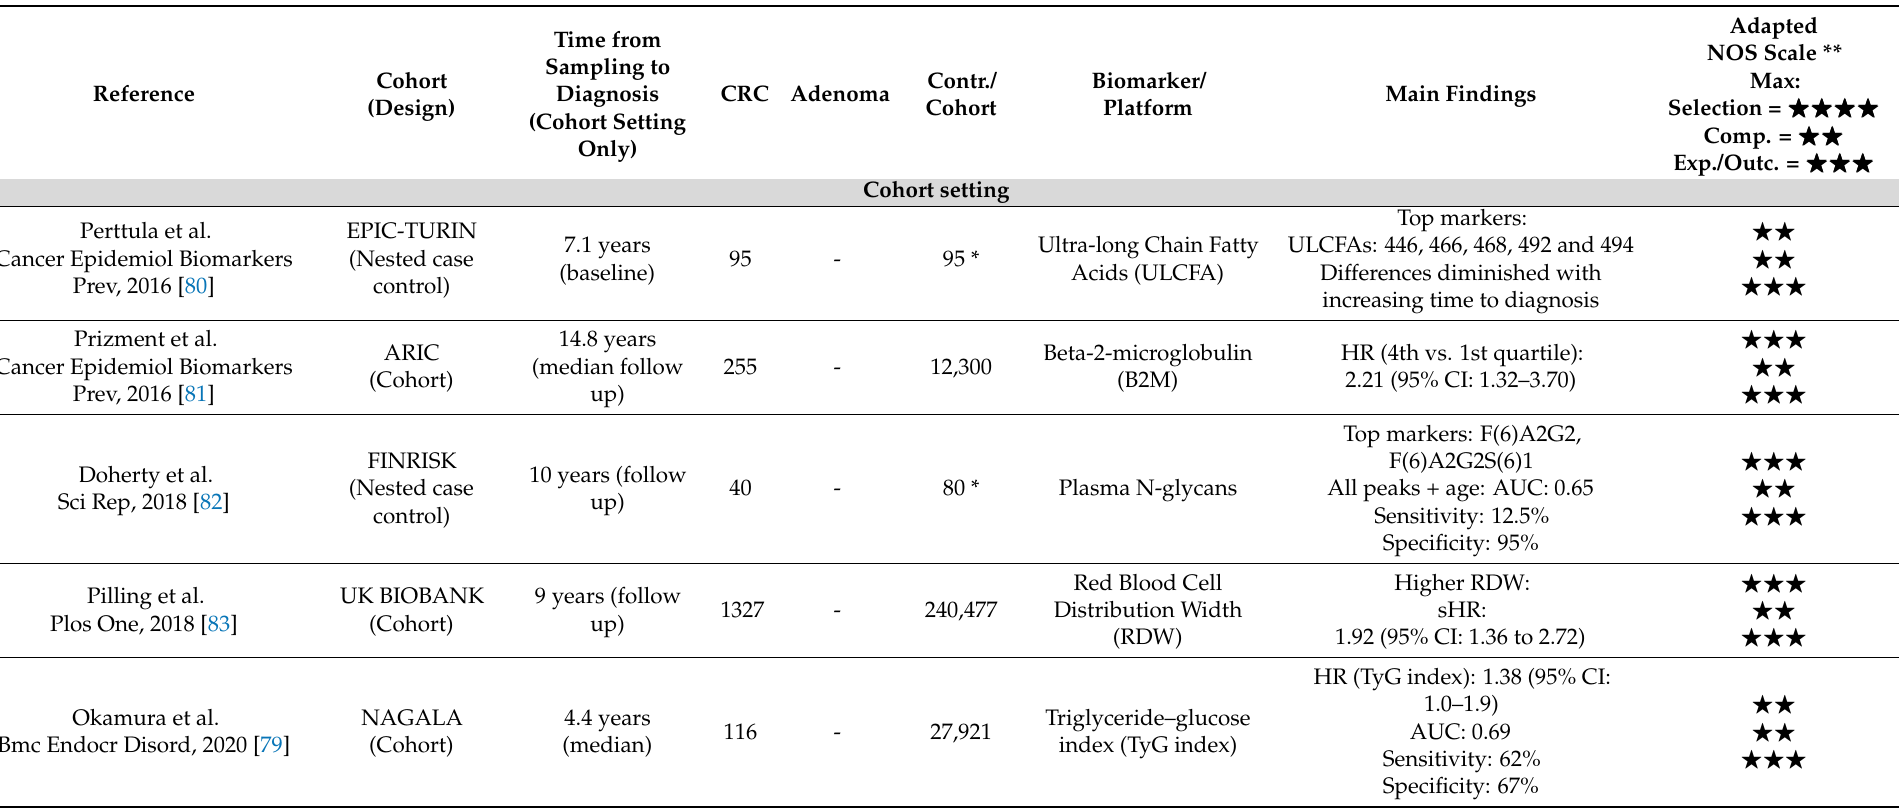
Table 5. Studies of other biomarkers analyzed in pre-diagnostic blood samples (collected in prospective cohort or general screening settings) for the purpose of risk prediction or early diagnosis of colorectal cancer.